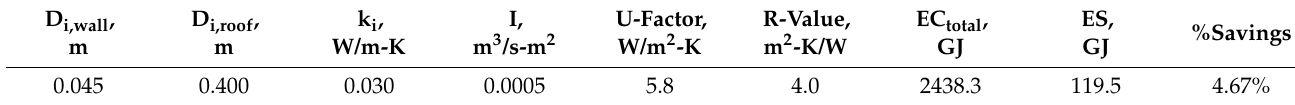
Figure 3. Parametric analysis of building envelope properties. Table 3. Resultant building envelope parameters.